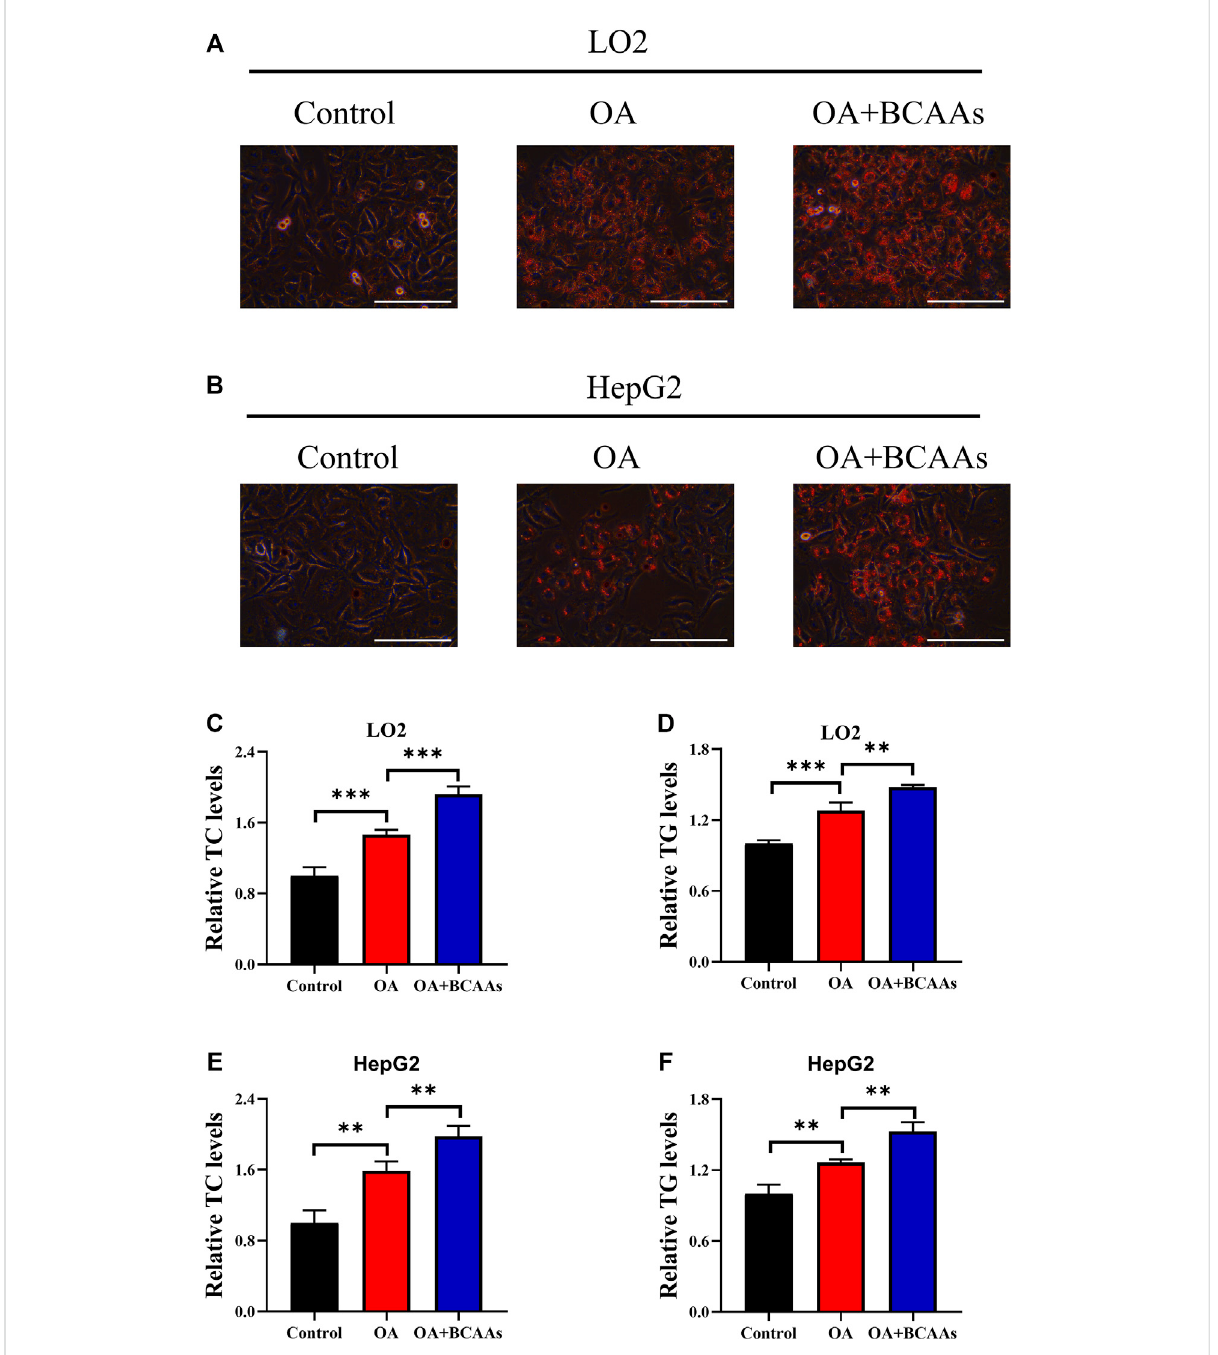
BCAAmetabolismcontributestoOA-inducedhepaticsteatosis. (A – F) LO2andHepG2cellswereincubatedwith0.5 mmOleicacidwithorwithout 10 mm BCAAs for 48 h. Intracellular lipid droplets were detected by Oil red O staining. Scale bar = 400 μ M (A,B) . Intracellular TC and TG levels in LO2 (C,D) and HepG2 (E,F) cells were detected. Data are shown as the mean ± SD of three independent experiments. ** p < 0.01, *** p <